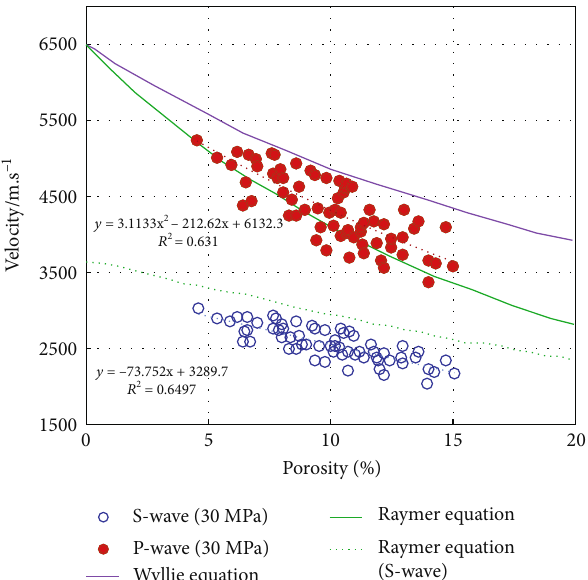
y = 3.1133x 2 – 212.62x + 6132.3 R 2 = 0.631